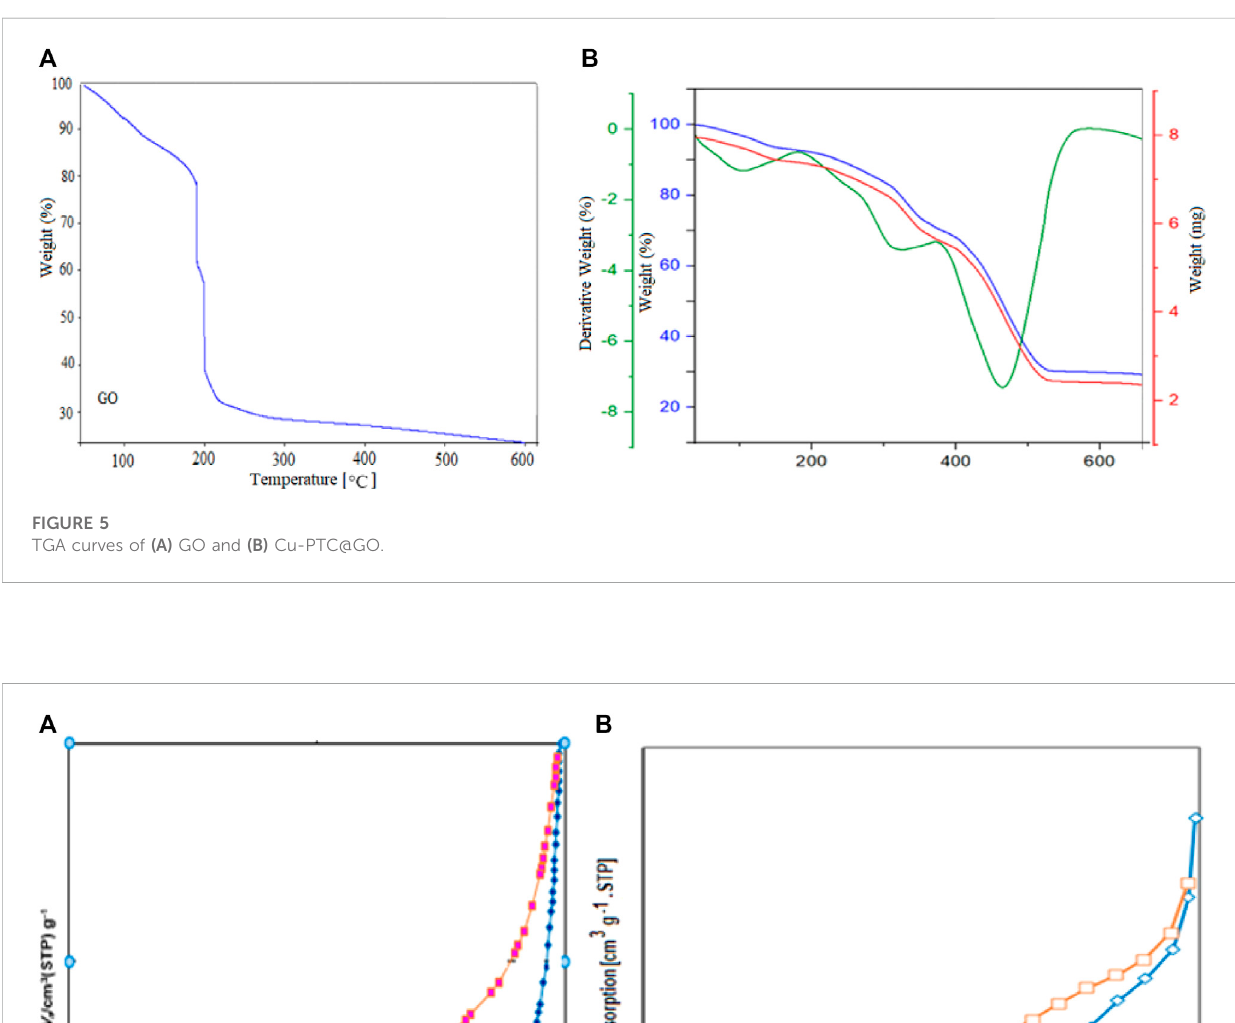
Figure 4 represents the element mapping images of the Cu- PTC@GO catalyst surface, with different colors indicating the presence of various elements after supporting Cu (PTC) onto surface GO. Figure 5 represents the thermal gravimetric analysis (TGA) of the GO and Cu-PTC@GO nanocatalyst. The TGA analysis was